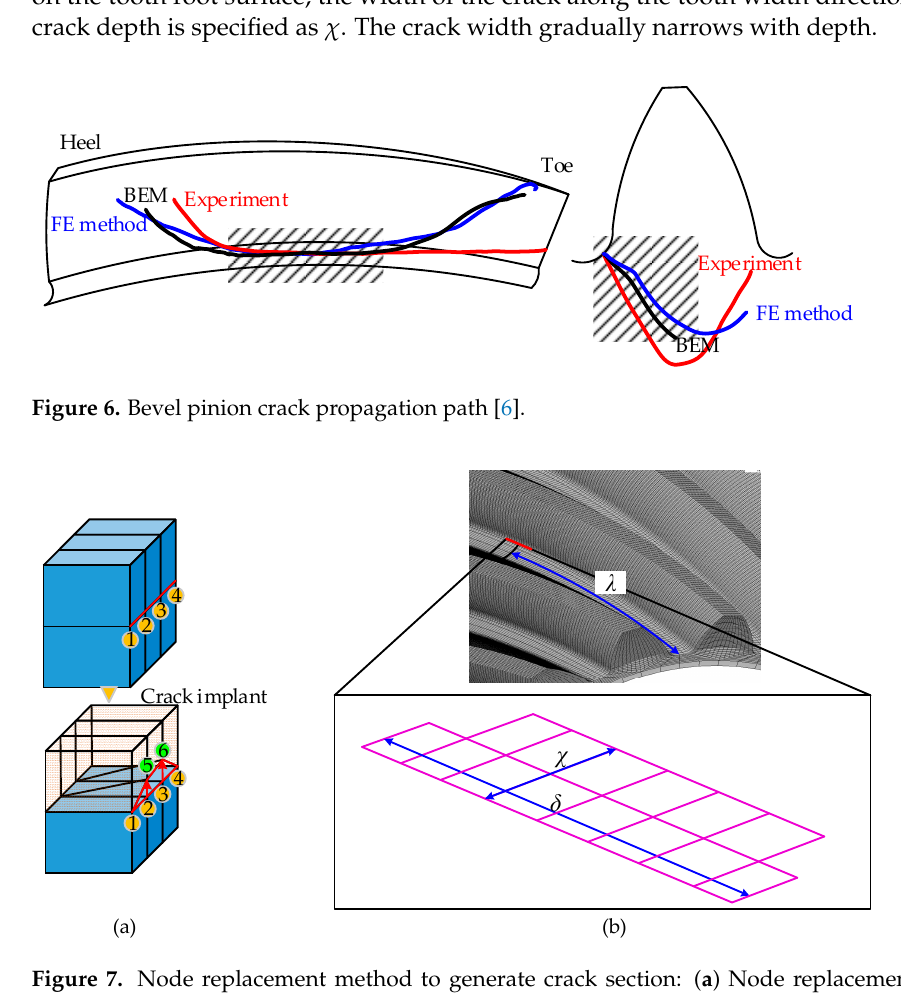
Figure 5. TVMS of the SBGP in a healthy state.